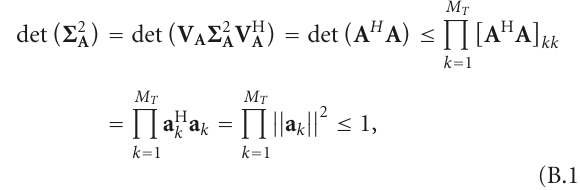
Figure 8: Comparison between capacity bound (47) for relaxed structured ASF and true capacity (15) of the resulted system in terms of empirical complementary cdf, when applied to a 16 × 4 MIMO Rayleigh i.i.d. channel with SNR = 15dB. Proof of this bound can be found in Appendix